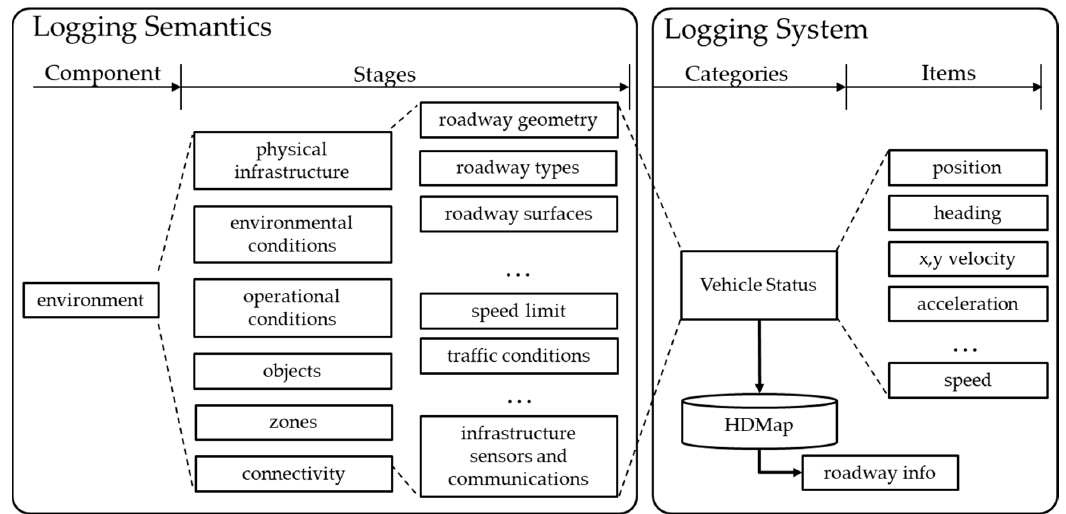
Figure 5. Environment component and logging items.